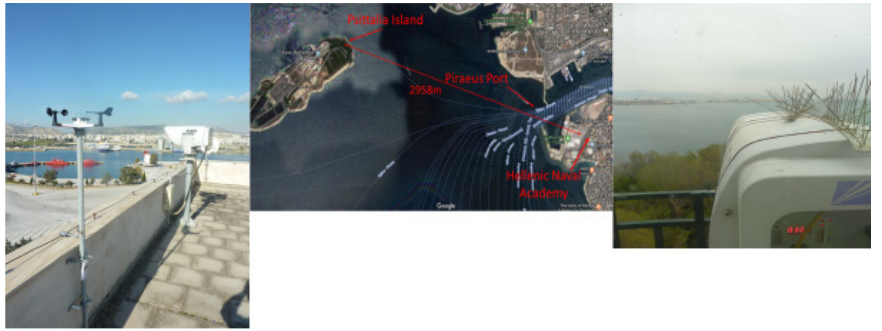
Figure 1. The MRV TS5000/155 model FSO system in HNA ( left ), the maritime FSO link propagation path ( center ) and the FSO terminal on the lighthouse of Psitalia Island ( right ).